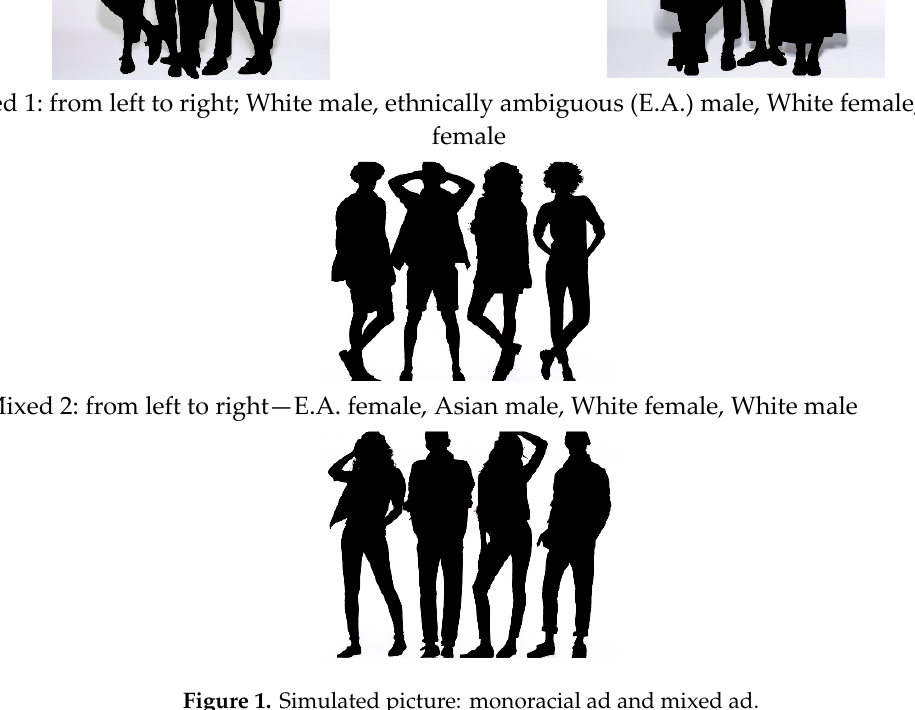
Figure 1. Simulated picture: monoracial ad and mixed ad.